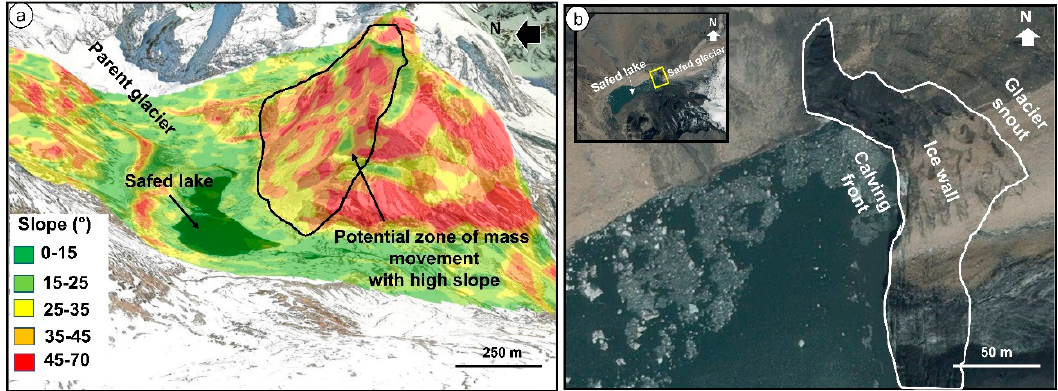
Figure 2. ( a ) The source zone of potential mass movements; ( b ) calving zone at the snout of the glacier. All images: Google Earth [19].